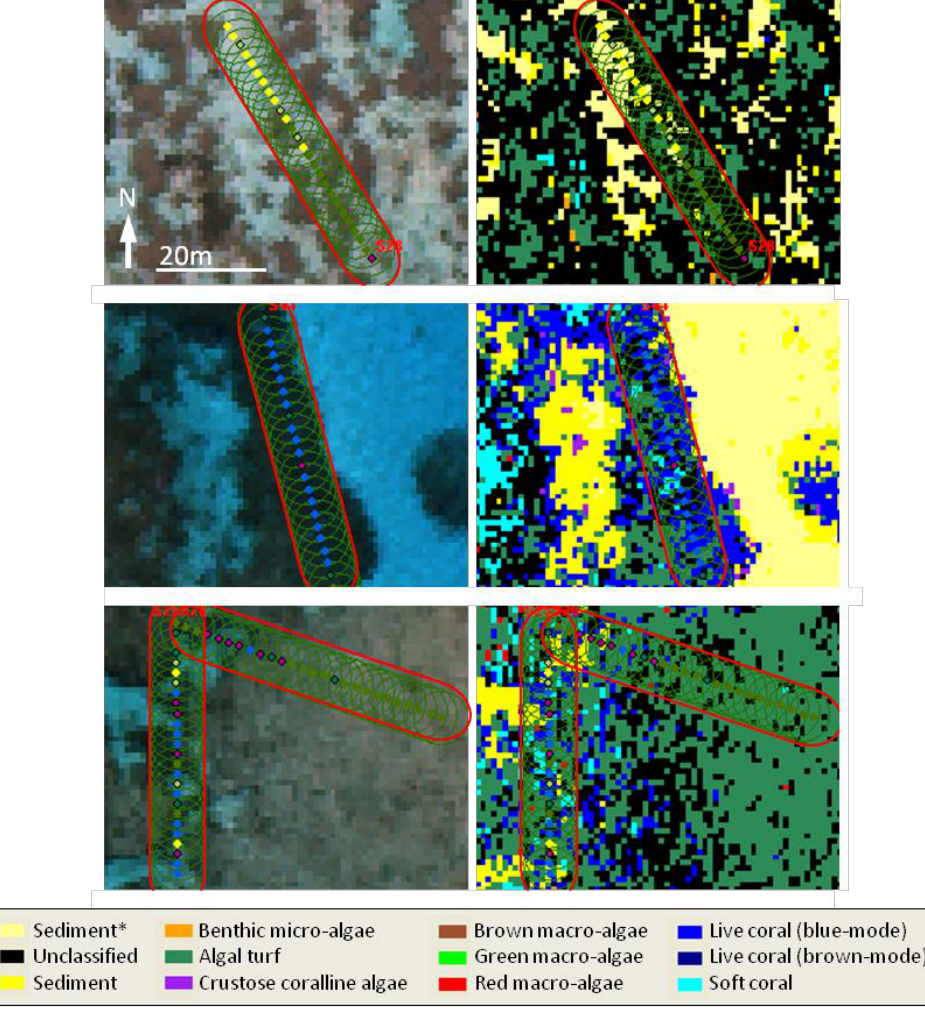
Figure 7. Examples of field validation transects, with a 5.0 m circular buffer around each point to account for spatial mis-registration. Transects were assessed for a match between the benthos and substrates within the buffer and the classified image. The snorkel transects shown above were considered to display a good match with the classified image, and were representative of the majority of